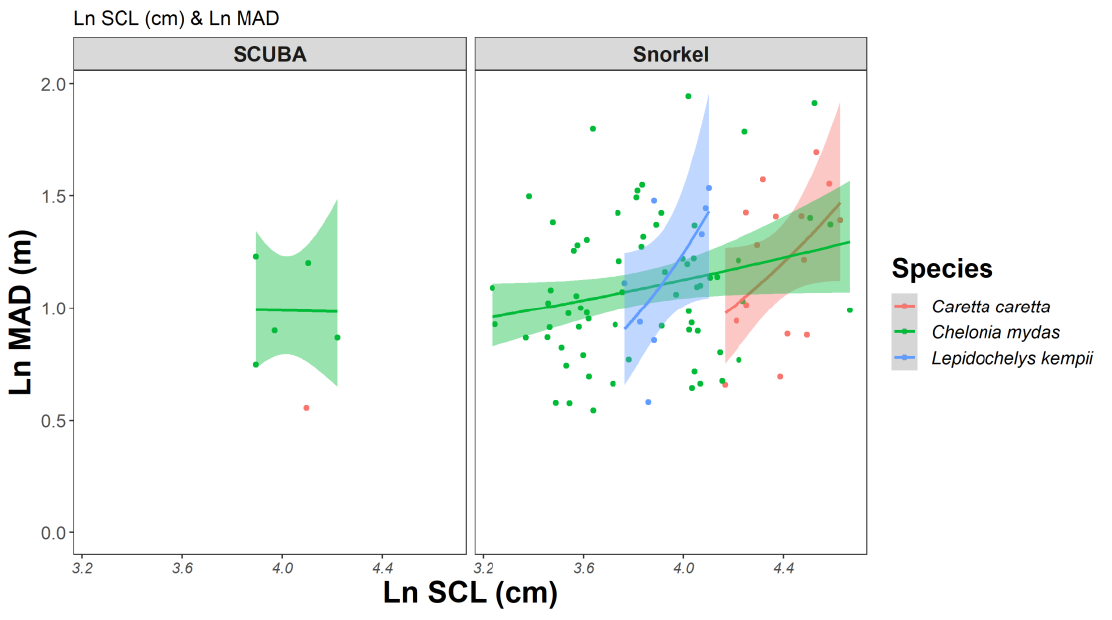
Figure 5. Linear mixed effects models (LM) of log-transformed MAD (m) and log transformed SCL (cm). The plots are differentiated by dive method and species of sea turtle observed. The solid line represents the predicted fit with shading for the 95% confidence interval.